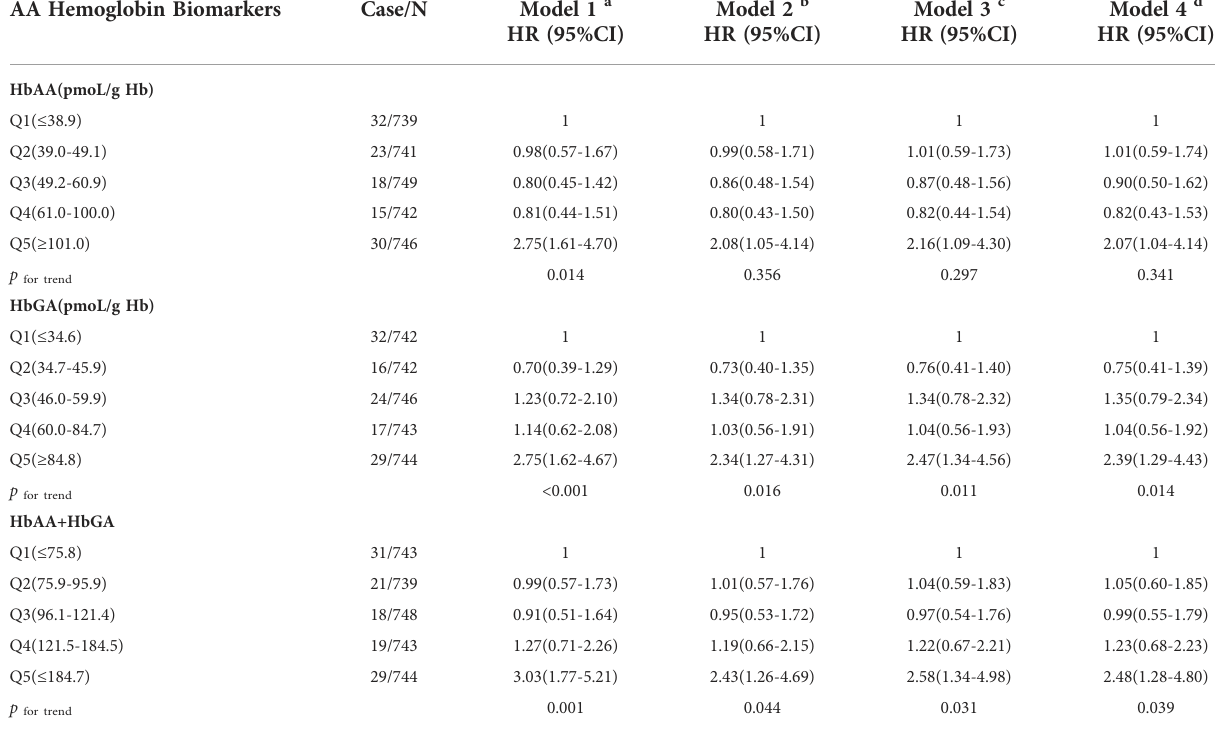
TABLE 2 Multivariate adjusted HRs of HbAA, HbGA and HbAA+HbGA for cancer mortality in total